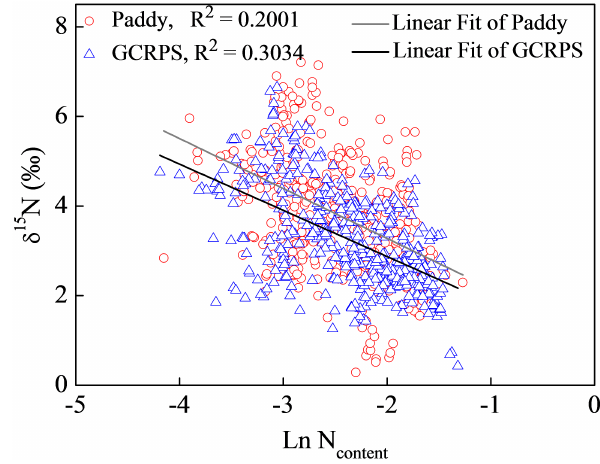
Figure 8. Correlation of δ 15 N with Ln-transformed soil total nitro- gen content up to 1m depth. Data presented are all the individual samples measured across the 49 paired sites, which consist of three replicates for each site ( n is